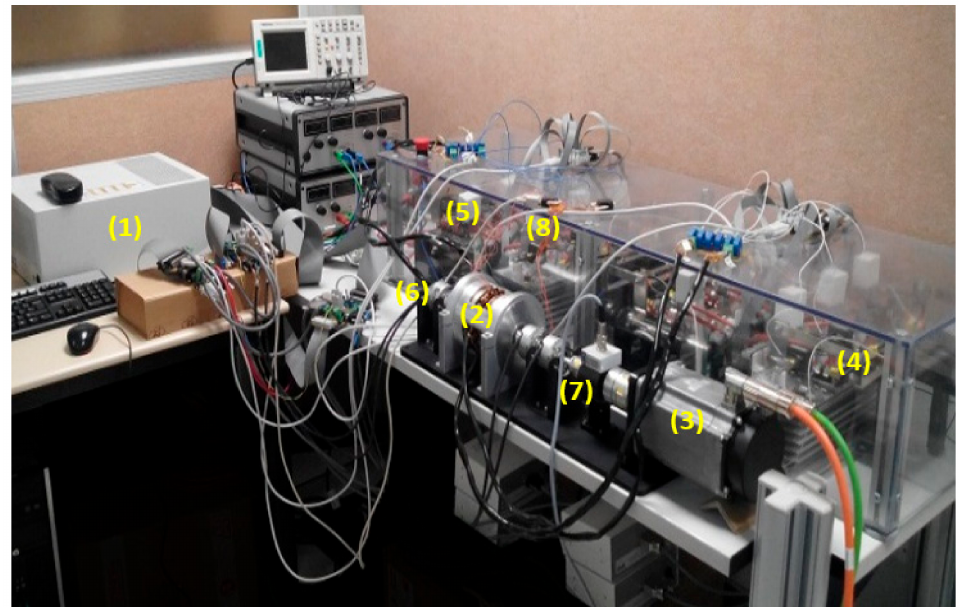
Figure 13. Test bench of the designed actuator. ( 1 ): dSPACE platform 1006. ( 2 ): Direct-Drive Actuator (prototype). ( 3 ): Load torque machine. ( 4) : Power electronic stages. ( 5) : Current sensors. ( 6 ): Position sensors. ( 7 ): Torque sensor. ( 8 ): Temperature sensor.